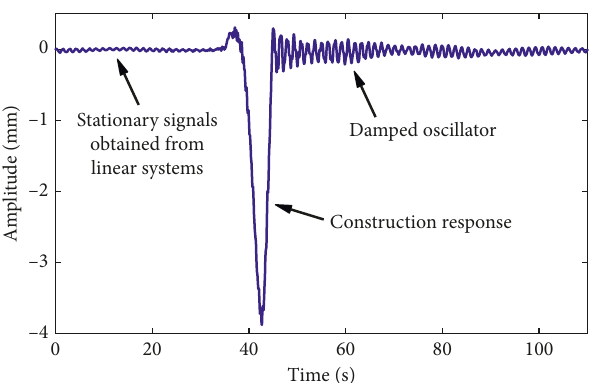
Figure 1: The decomposition of the measurement signal (repro- duced from [24], under the Creative Commons Attribution- NonCommercial 4.0 International License).